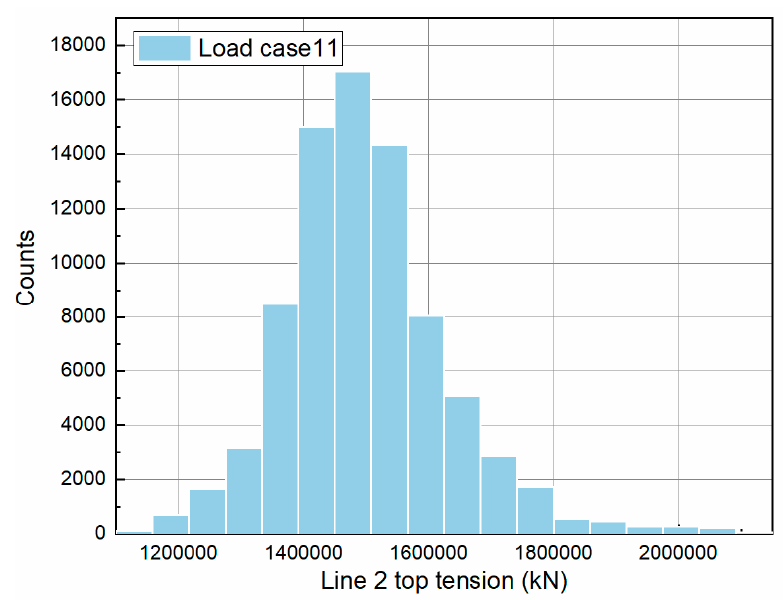
Figure 10. Histogram of most loaded mooring line tension of load case 11 (slack mooring).